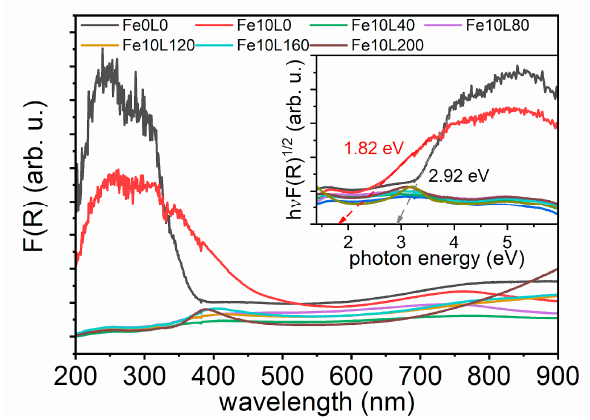
Figure 8. Absorbance spectra and Tauc plots (inset) for laser-treated Fe-decorated TiO 2 -NTs.